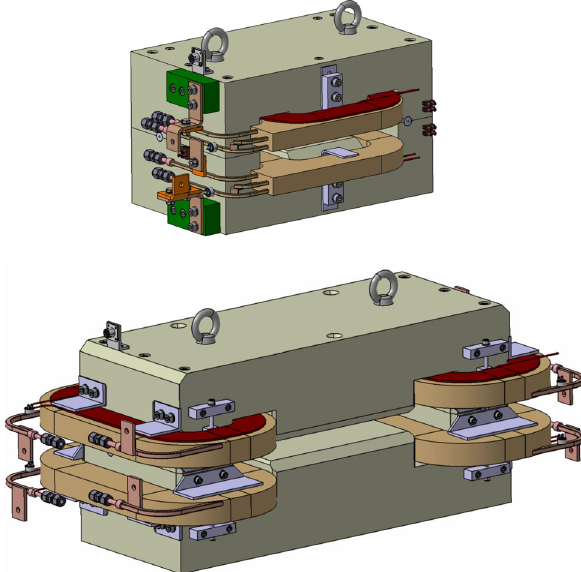
FIG. 28. The two dipole magnet designs tested in the SITF bunch compressor. Top: original design with pole windings. Bottom: second design with larger pole width, later discarded because of the long-range stray fields resulting from the return- yoke